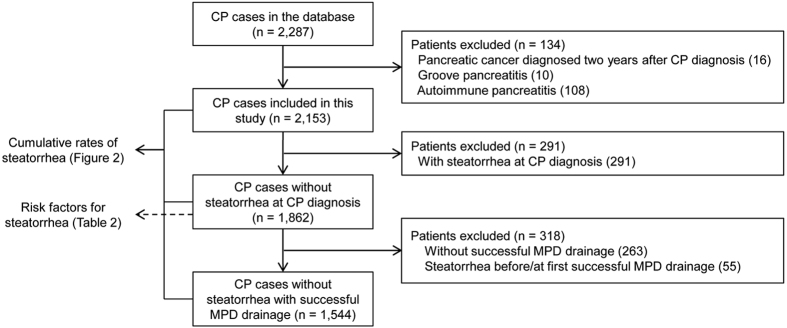
Different analyses employed for different patients.